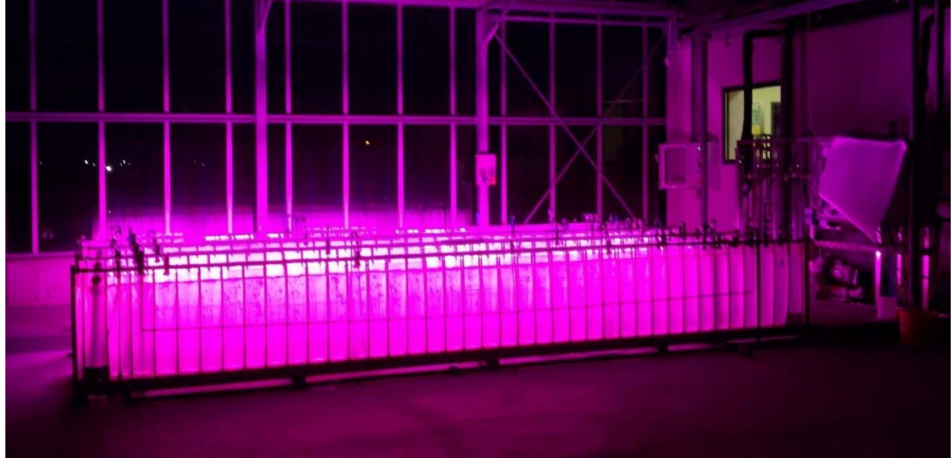
Figure 2. Green Wall Panels ® (Fotosintetica & Microbiologica S.r.l.—Florence, Italy) illuminated by LED (Courtesy of Azienda Agricola Serenissima—Padova,